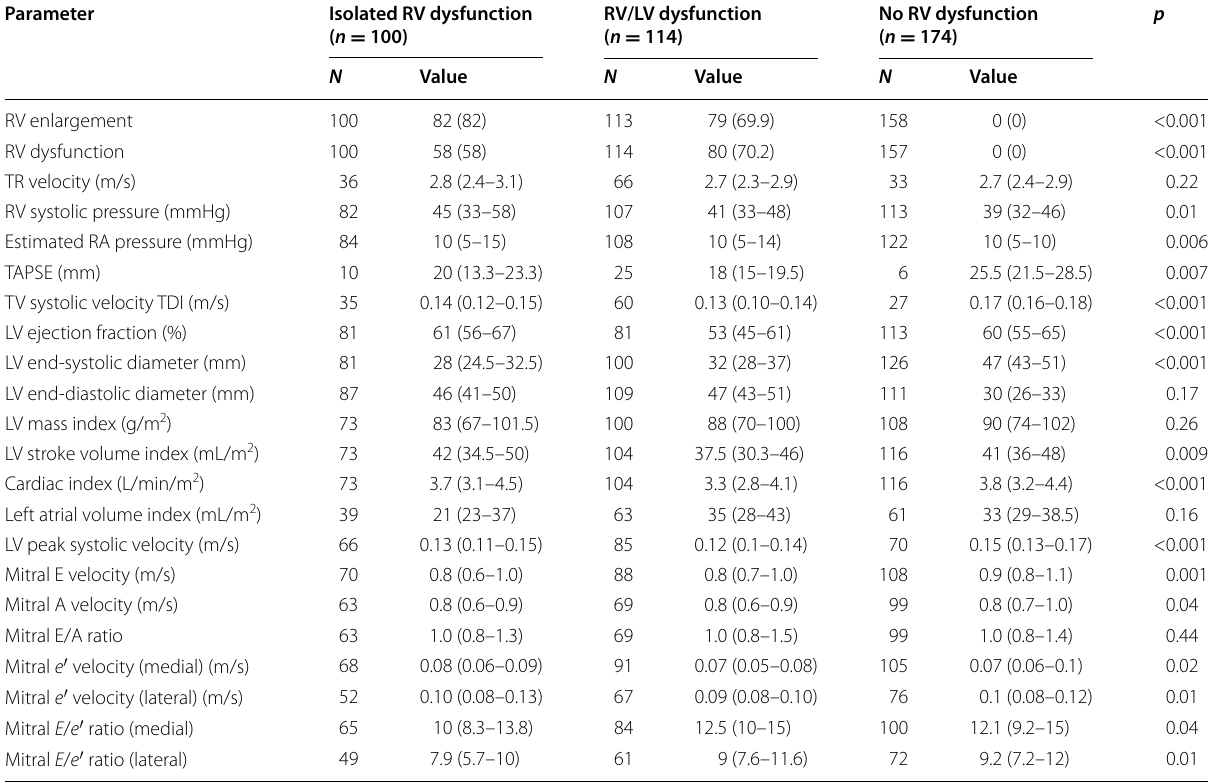
Represented as : total (percentage) or median (interquartile range) LV left ventricle, RA, right atrial, RV right ventricular, TAPSE tricuspid annular plane systolic excursion, TDI tissue Doppler imaging, TR tricuspid regurgitation, TV tricuspid valve *Not all parameters were measured in all patients. Individual n for each cohort is presented in the